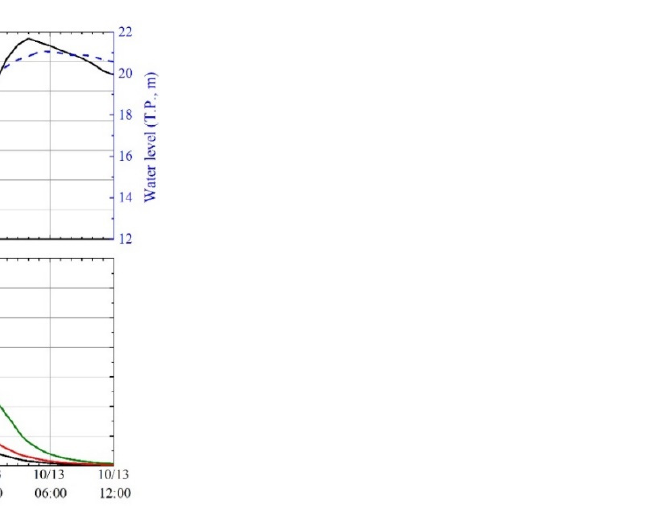
Figure 6. ( a ) Abukuma River discharge and water level from MLIT. ( b ) River discharge outputs from the rainfall-runoff-inundation (RRI) model for Uchi River, Gofukuya River, and Shin River at the boundary locations.